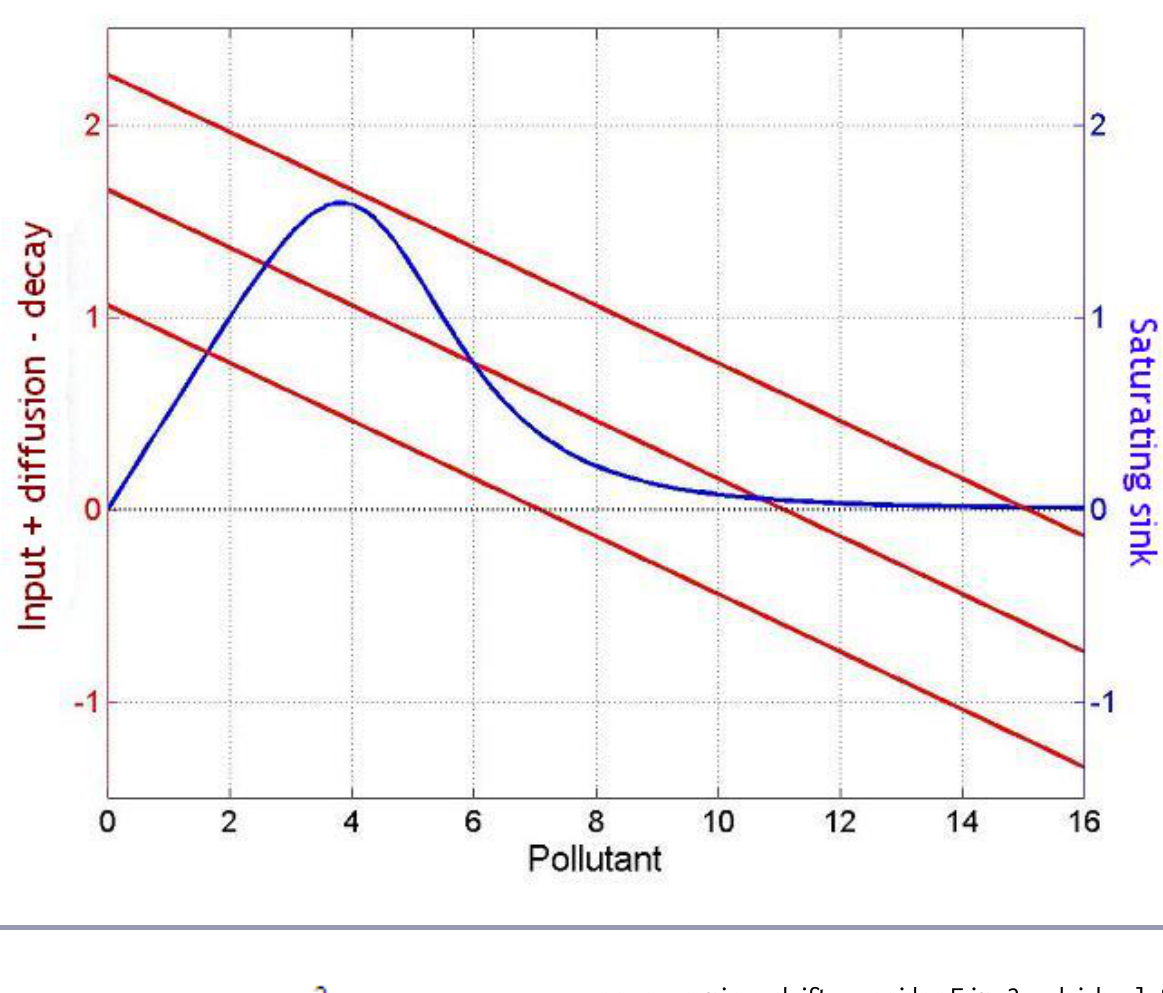
Fig. 2 . Rate of input + diffusion - decay (red lines) for three values of pollutant discharge in region 1, M 1 (0.9, 1.5, and 2.1), and the rate of loss from the saturating sink (blue line). For a given minimum pollution rate in region 1, M , equilibria occur at the points at which the red line crosses the blue line. 1 The pollutant level in the other region was set at 1.6. Other parameters: M (pollution discharge rate in 2 region 2) = 0.75; D (transport rate between regions) = 0.1; c (decay rate) = 0.05; s (maximum sequestration rate) = 0.5; m (pollutant level at which sequestration is half the maximum rate) = 5; q, which determines the slope of f(P) near P = m, = 6. P stands for amount of pollutant, and f(P) scales the sequestration to the amount of